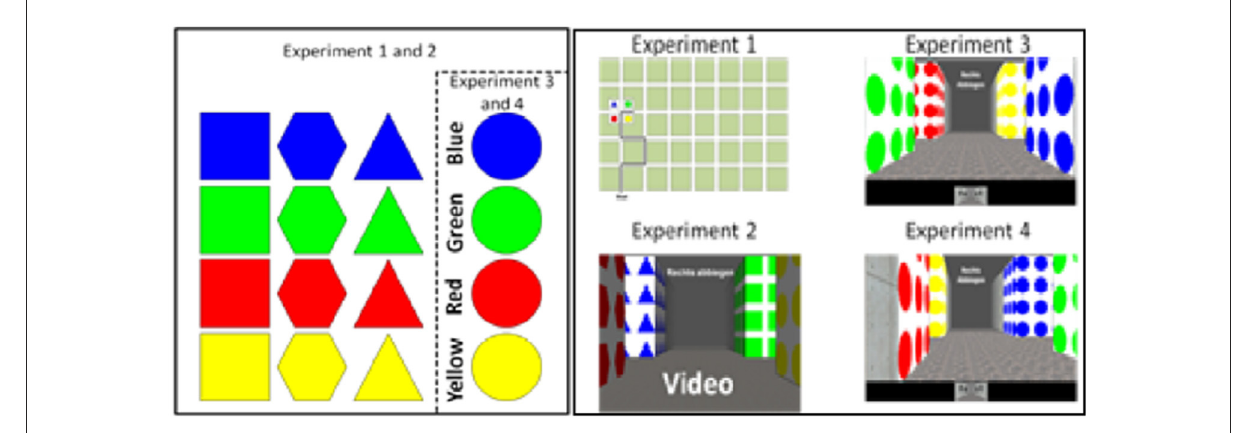
FIGURE2 Materials and setups used in the experiments.